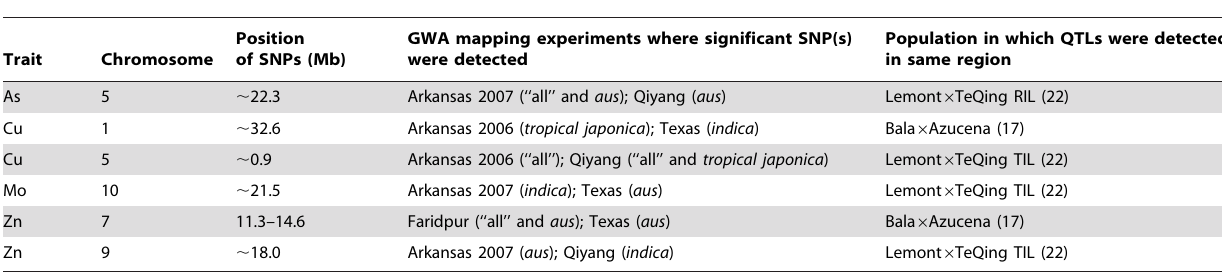
Table 3. Co-localisation of significant SNPs from multiple field experiments detected in this study and previously detected QTLs.